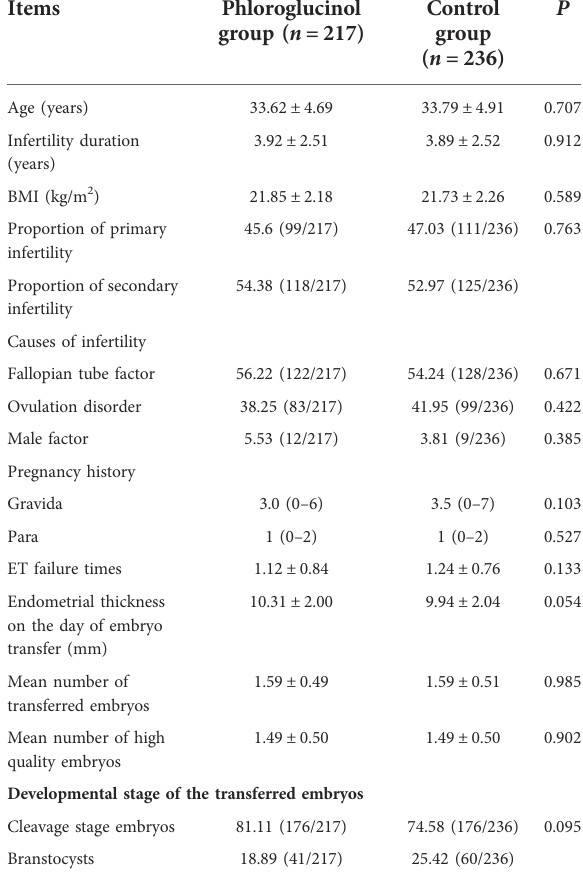
TABLE 1 Comparison between two groups of patients in terms of general information.